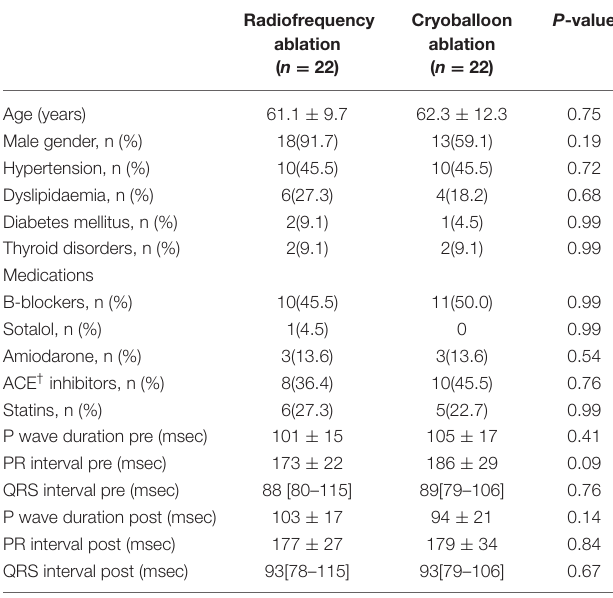
TABLE 1 | Patient and ECG characteristics by ablation method.